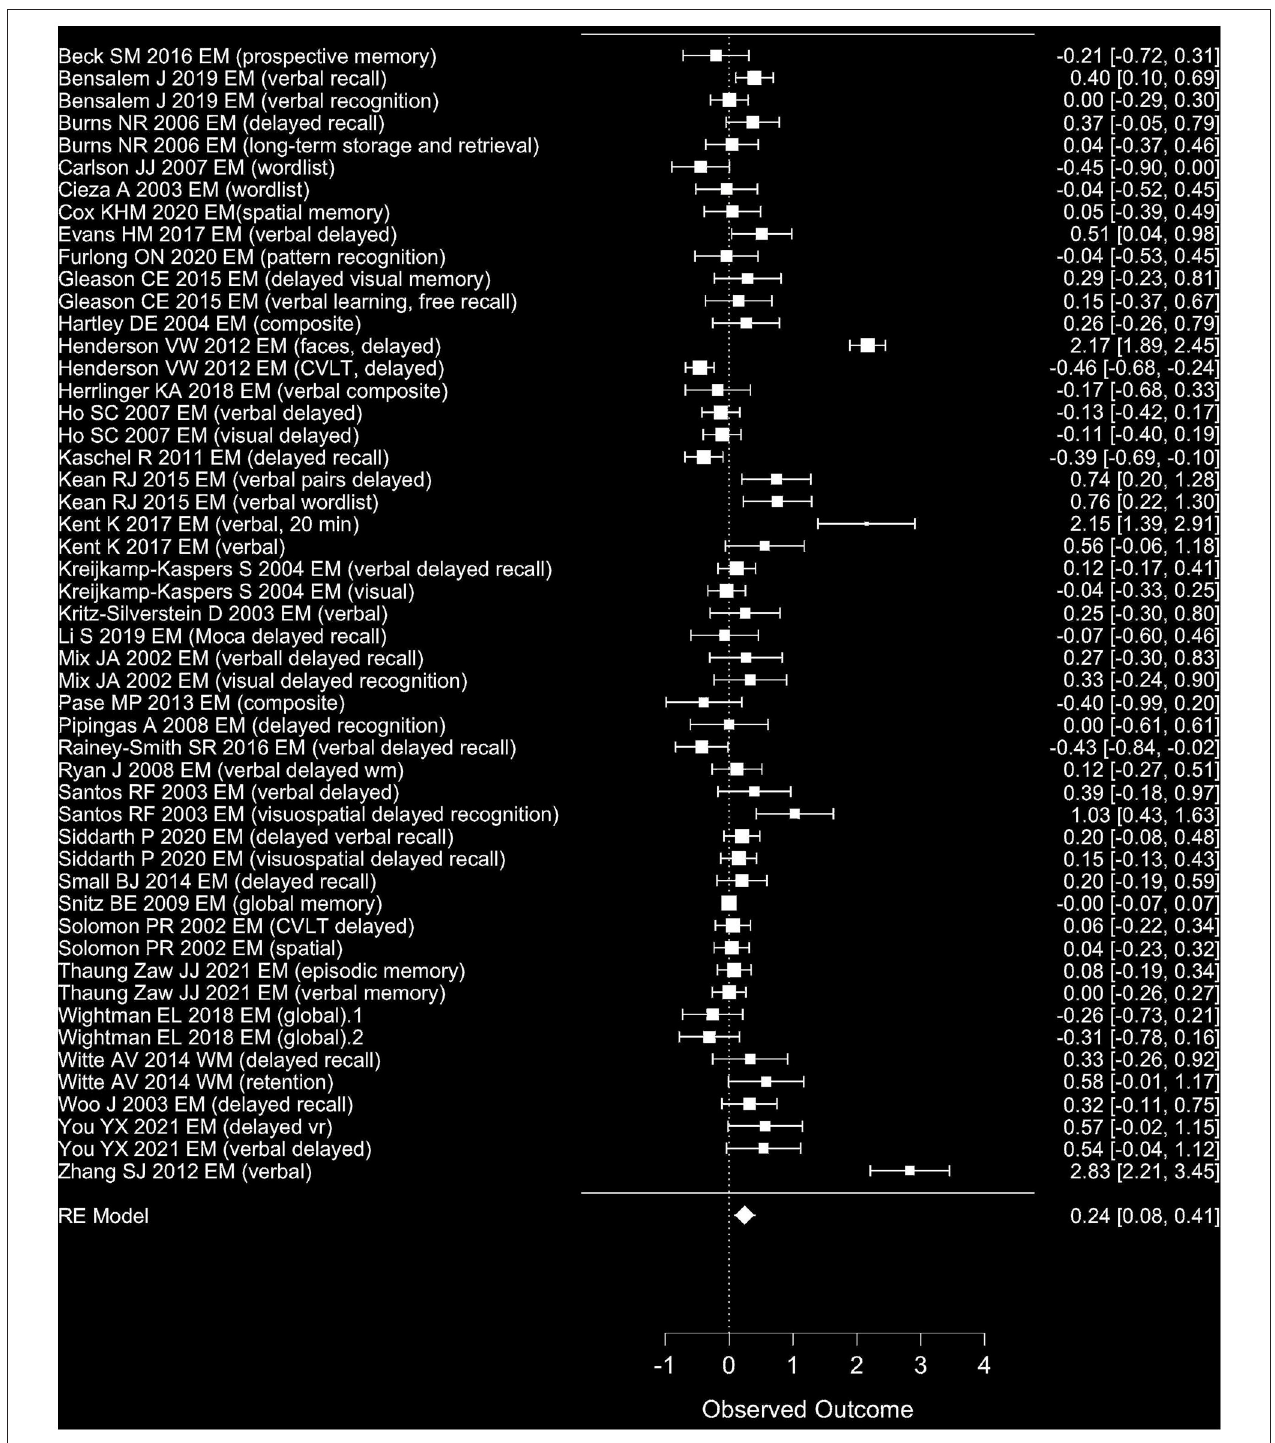
FIGURE 4 | Forest plot for observed effect sizes (d) and standard errors (SE) for available study results for EM. RE, regression estimate.